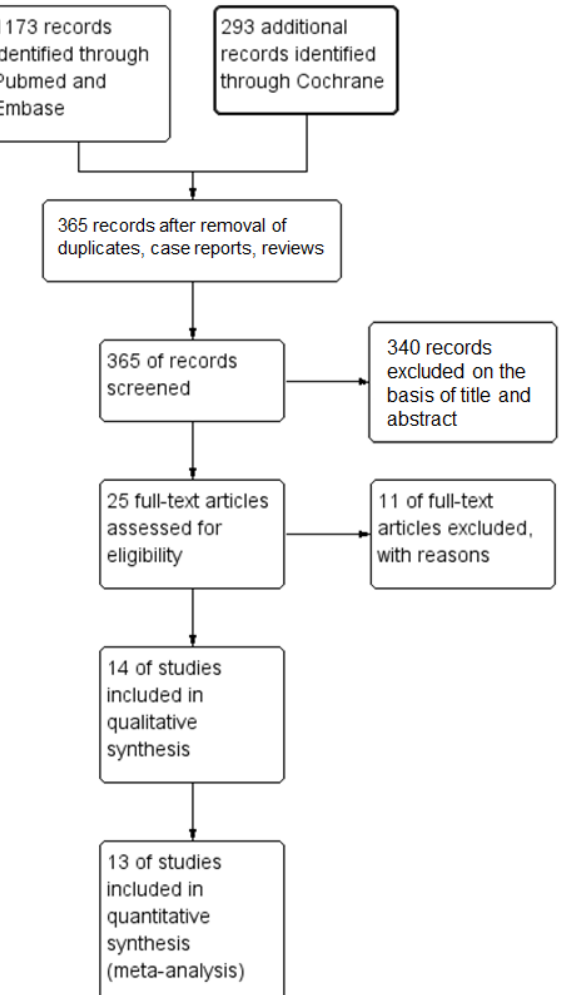
Figure 2. Flow chart of the study eligibility assessment performed according to the Preferred Reporting Items for Systematic Reviews and Meta-Analyses guidelines (PRISMA).